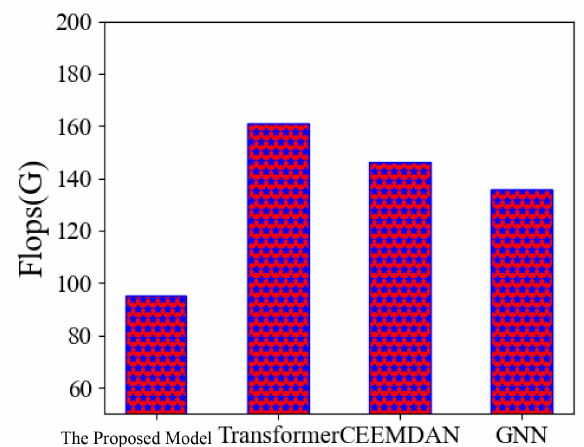
Figure 10. Comparison of the amount of operations in different models.